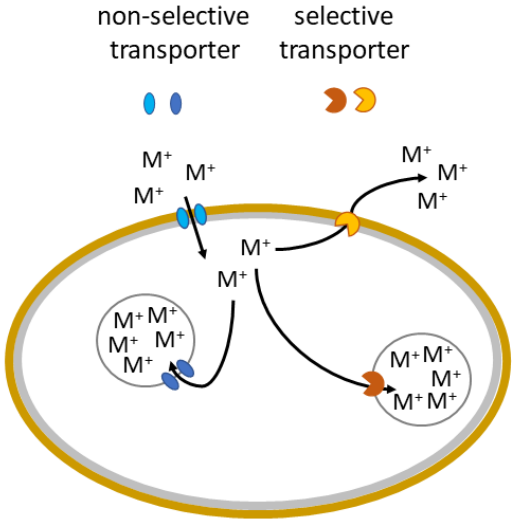
Figure 4. Bioaccumulation, compartmentation, and efflux of metals in fungi.